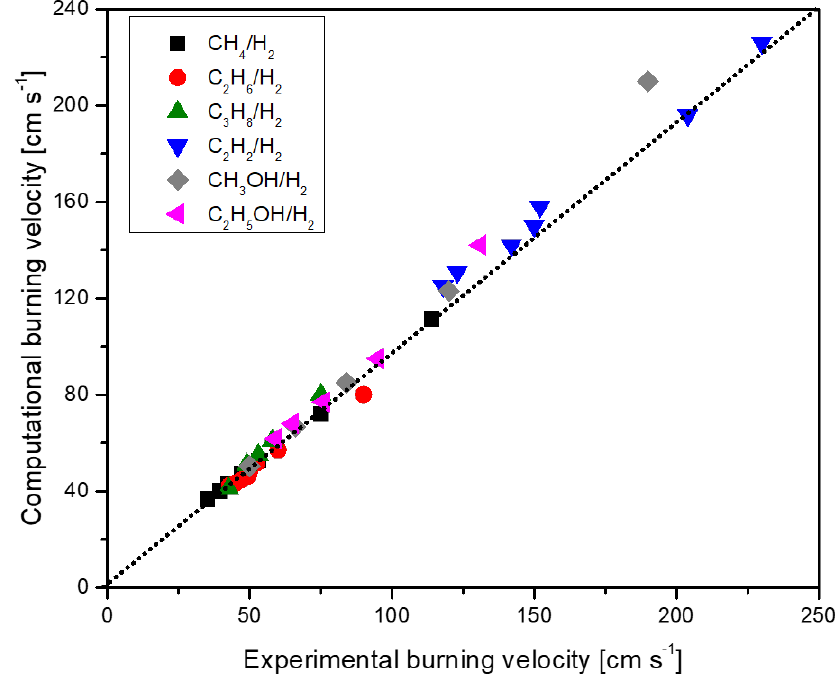
Figure 3. Comparison of experimental laminar burning velocity with its estimated values.